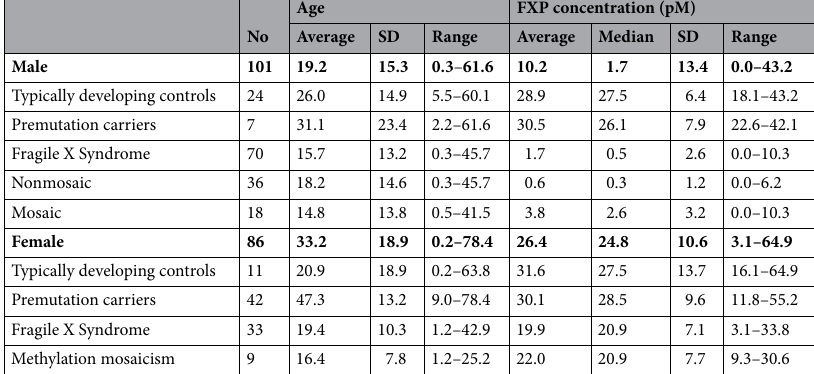
Table 1. Demographic information. FXP Fragile X Protein, SD Standard